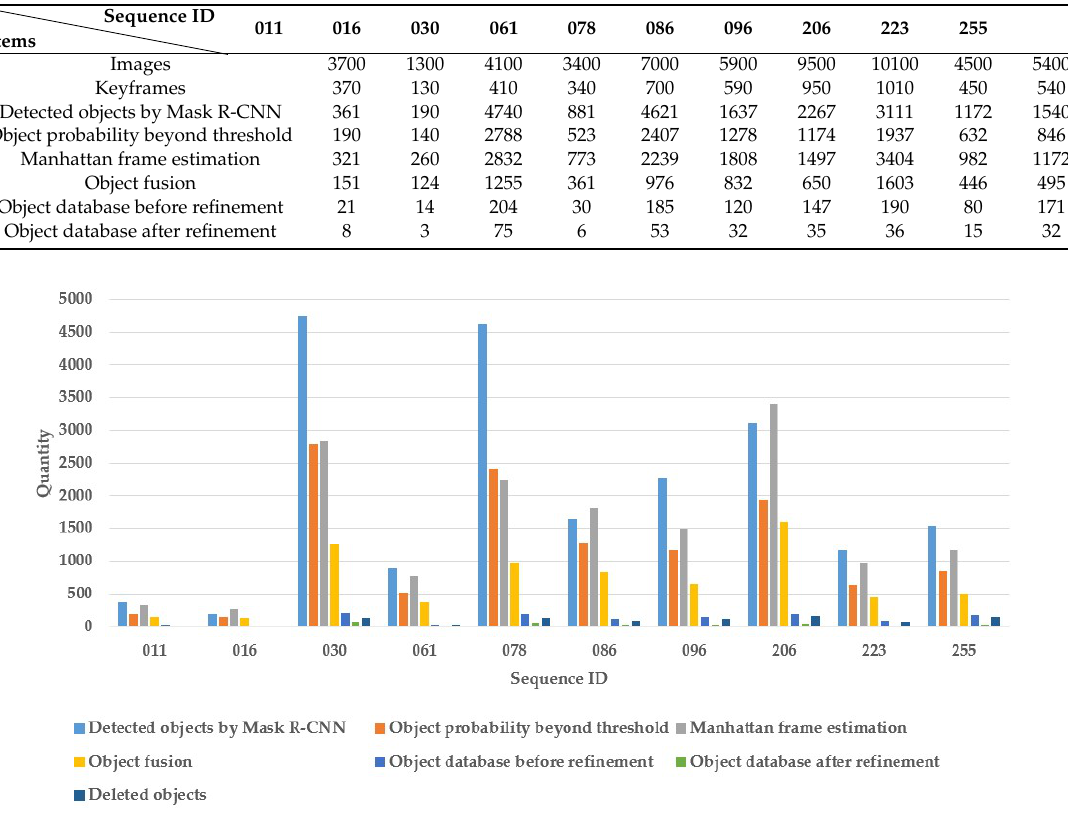
Table 4. Details of experiments on 10 sequences of SceneNN dataset.